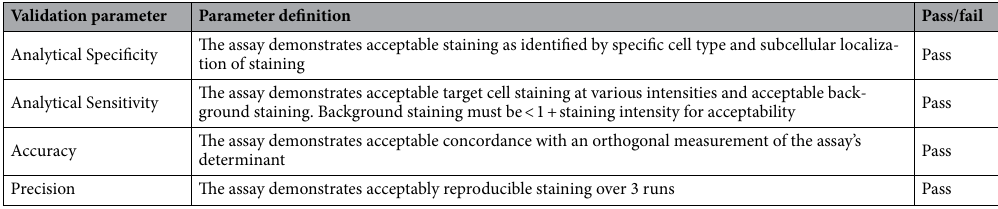
Table 1. Validation parameters of the PD-L1 digital